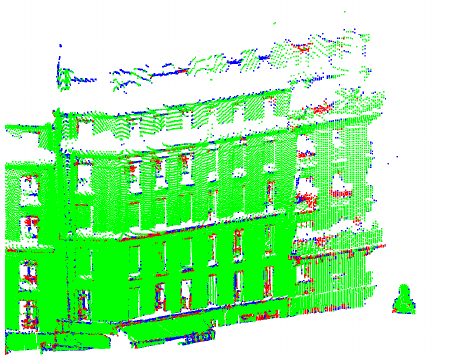
Figure 4: Dimensionality labeling for a building facade (Blue: 1D; Green: 2D; Red: 3D).